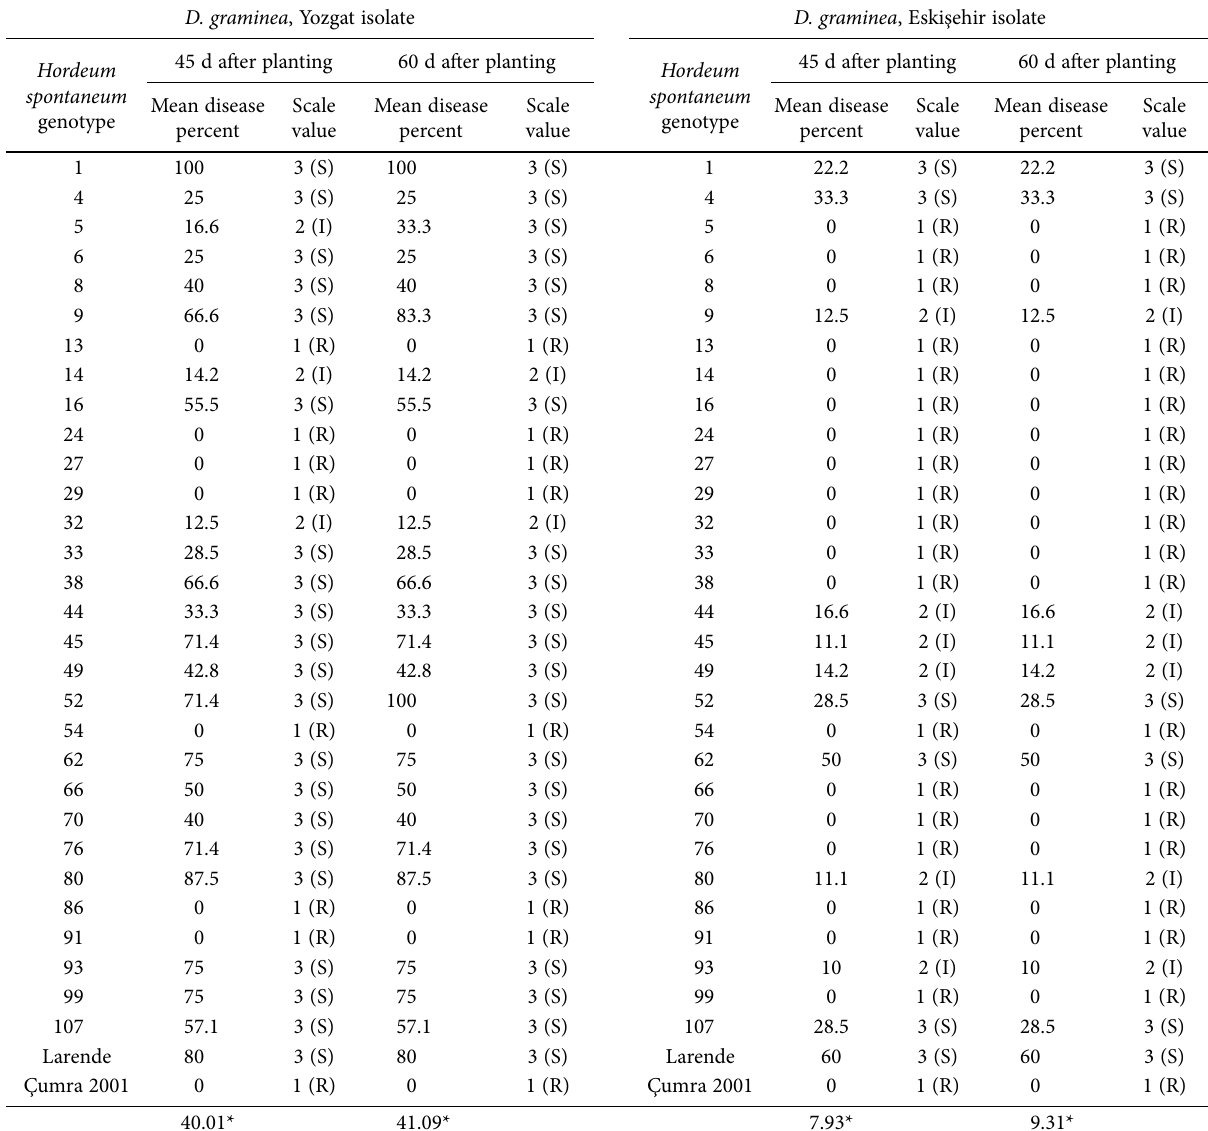
Table 5. Reactions of 30 wild barley ( Hordeum spontaneum ) genotypes following inoculation with two isolates of Drechslera graminea . For disease values, the scale of Tekauz (1983) was